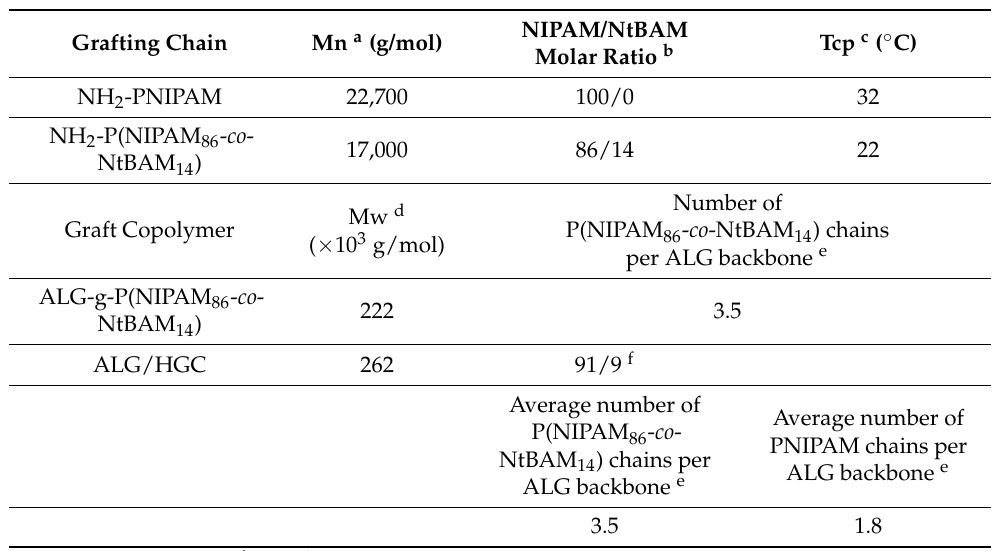
Table 1. Molecular characteristics of ALG/HG